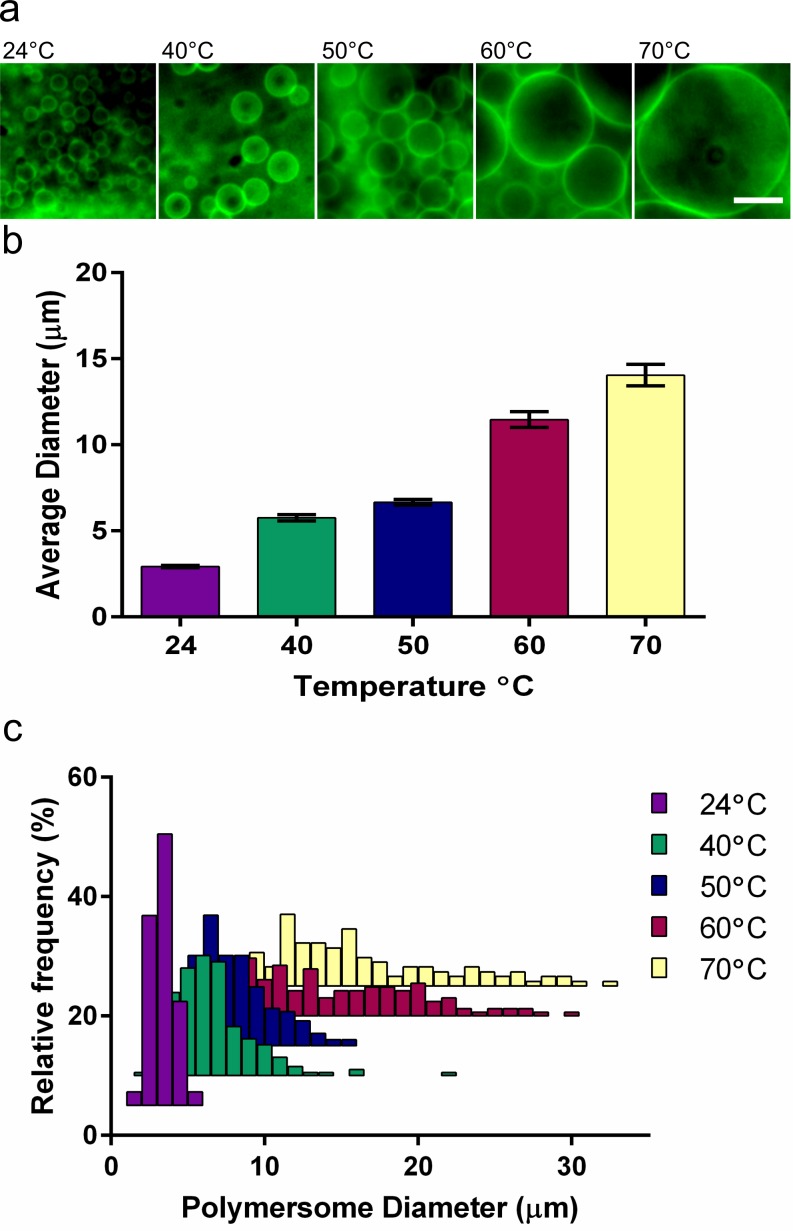
Dependency of vesicle size on different rehydration temperatures.PEO-PBD polymersomes were generated in water on 1% agarose gels for 30 min at varying temperatures on a hot plate. (a) Epifluorescence photomicrographs (scale bar = 10 μm), (b) average diameters (± standard error of the mean), and (c) frequency distribution plots for polymersomes formed at different temperatures.